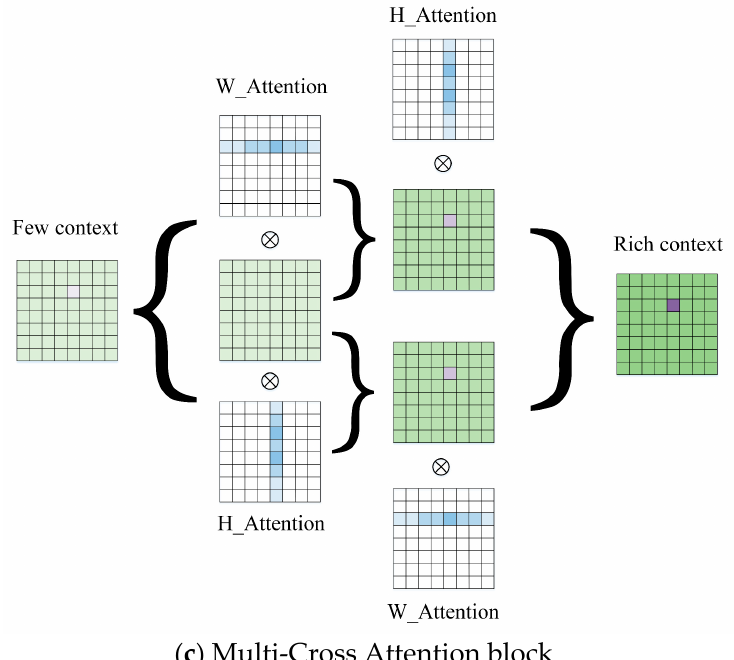
Figure 3. Diagram of three approaches to attentional context aggregation. The white and blue grids are different attention modules. The green grids are original feature images that changed through the attention modules. ( a ) A common non-local block with a global feature aggregation [36]. For each pixel, the aggregated result is obtained through intensive mapping with different weight allocations. ( b ) A Criss-cross Attention block [35]. The different weights are assigned in the horizontal and vertical directions serially. ( c ) A Multi-Cross Attention block that is different from ( b ). We adopted the structure in horizontal and vertical directions in parallel and separately to aggregate features more adequately. At the same time, we retained the residual connection to achieve a better feature aggregation effect.